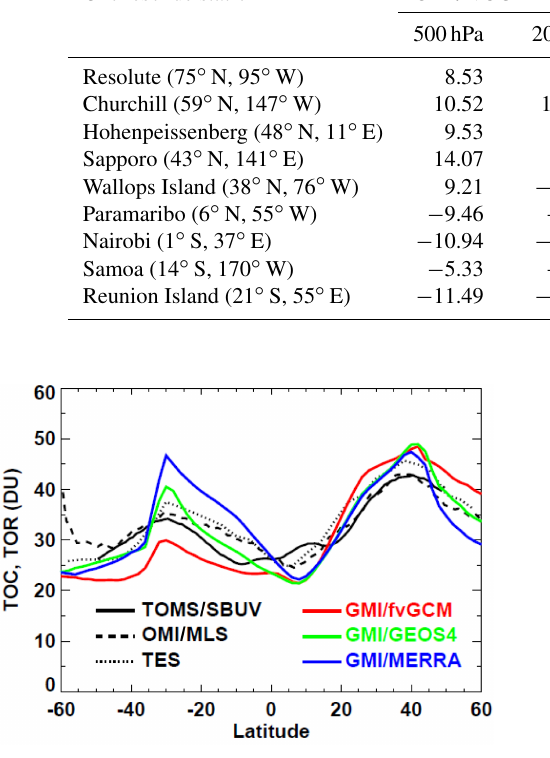
Figure 7. GMI-simulated zonal mean tropospheric ozone columns (TOCs) compared with tropospheric ozone